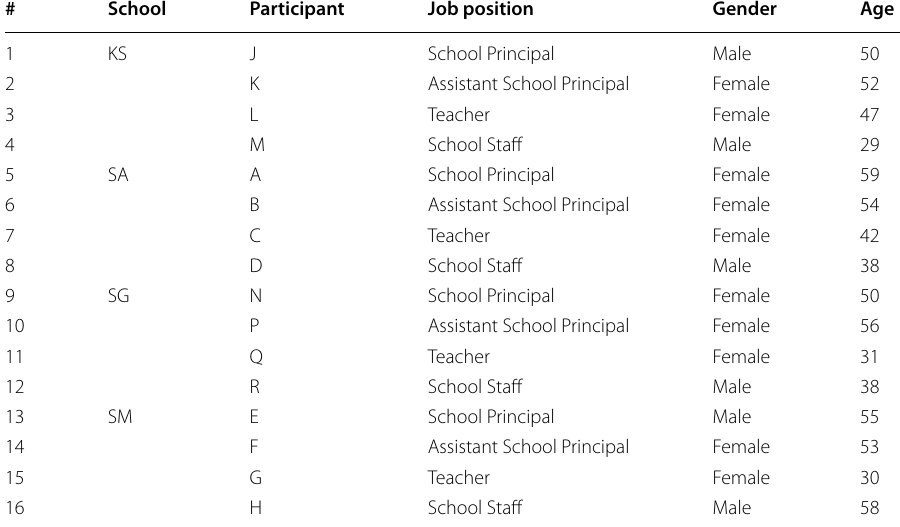
Table 2 Summary of Participant